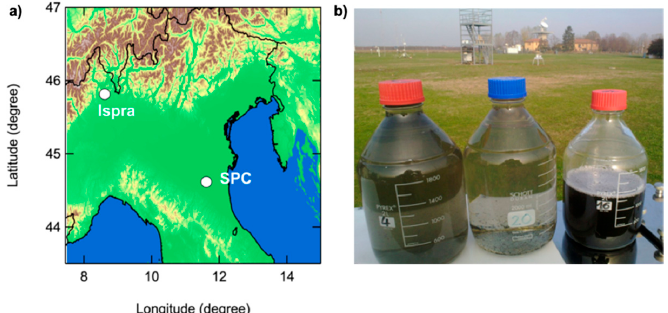
Figure 1. Map of Northern Italy, reporting the measurement sites San Pietro Capofiume (SPC) and Ispra ( a ); example of fog water samples collected at SPC ( b ). The different content of elemental carbon (EC) is visually shown by the blackness of the different samples.